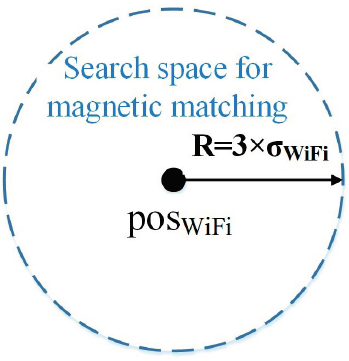
Figure 3. Using WiFi positioning results to limit search space for magnetic